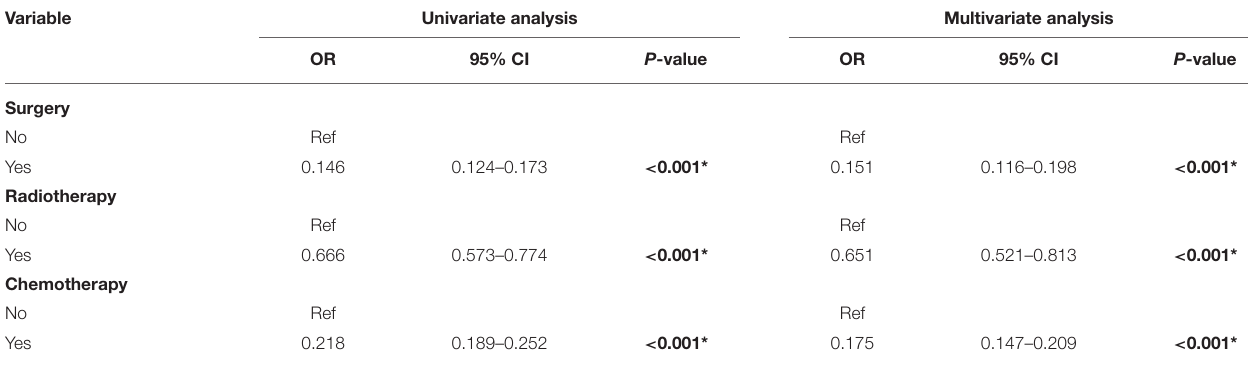
1 year in patients with mRCC after first-line tyrosine kinase inhibitors (TKIs) administration. In our study, we defined it as survival ≤ 3 months according to the previous definition of early death (10, 21). The early mortality rates from all cause and